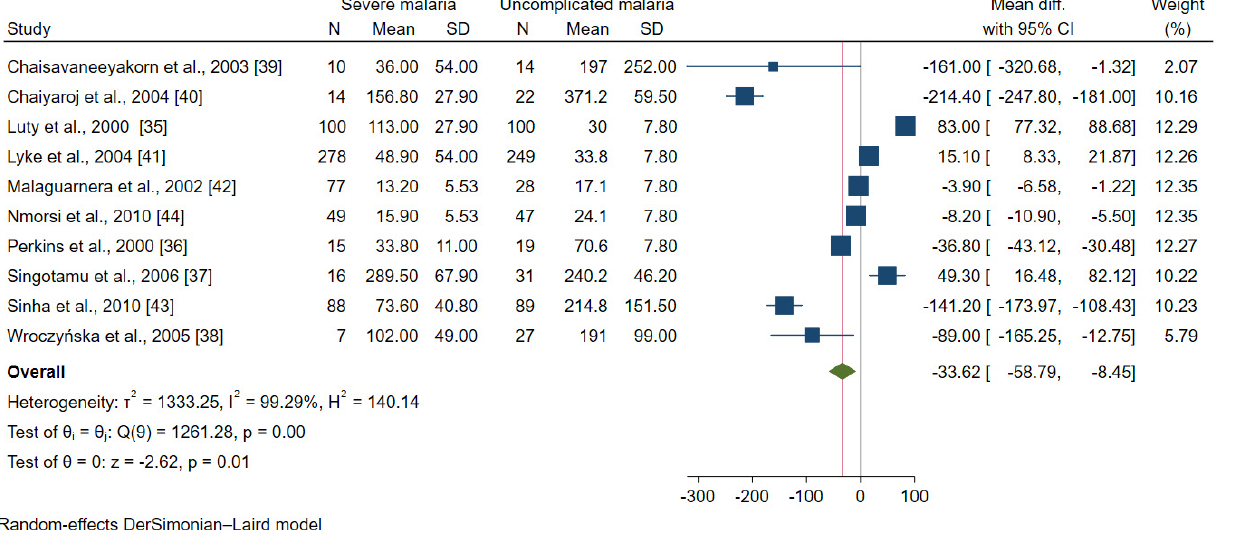
Figure 2. Forrest plot demonstrated the difference in the mean IL-12 levels (pg/mL) between patients with severe malaria and uncomplicated malaria [35–44]. Abbreviation: Mean Diff., mean difference; CI, confidence interval. Explanation of the forest plot: squared-box symbol, point estimate; green diamond and red line: pooled mean difference: blue line: line of no effect; I 2 , level of heterogeneity; p = 0.00 or less than 0.05, significant